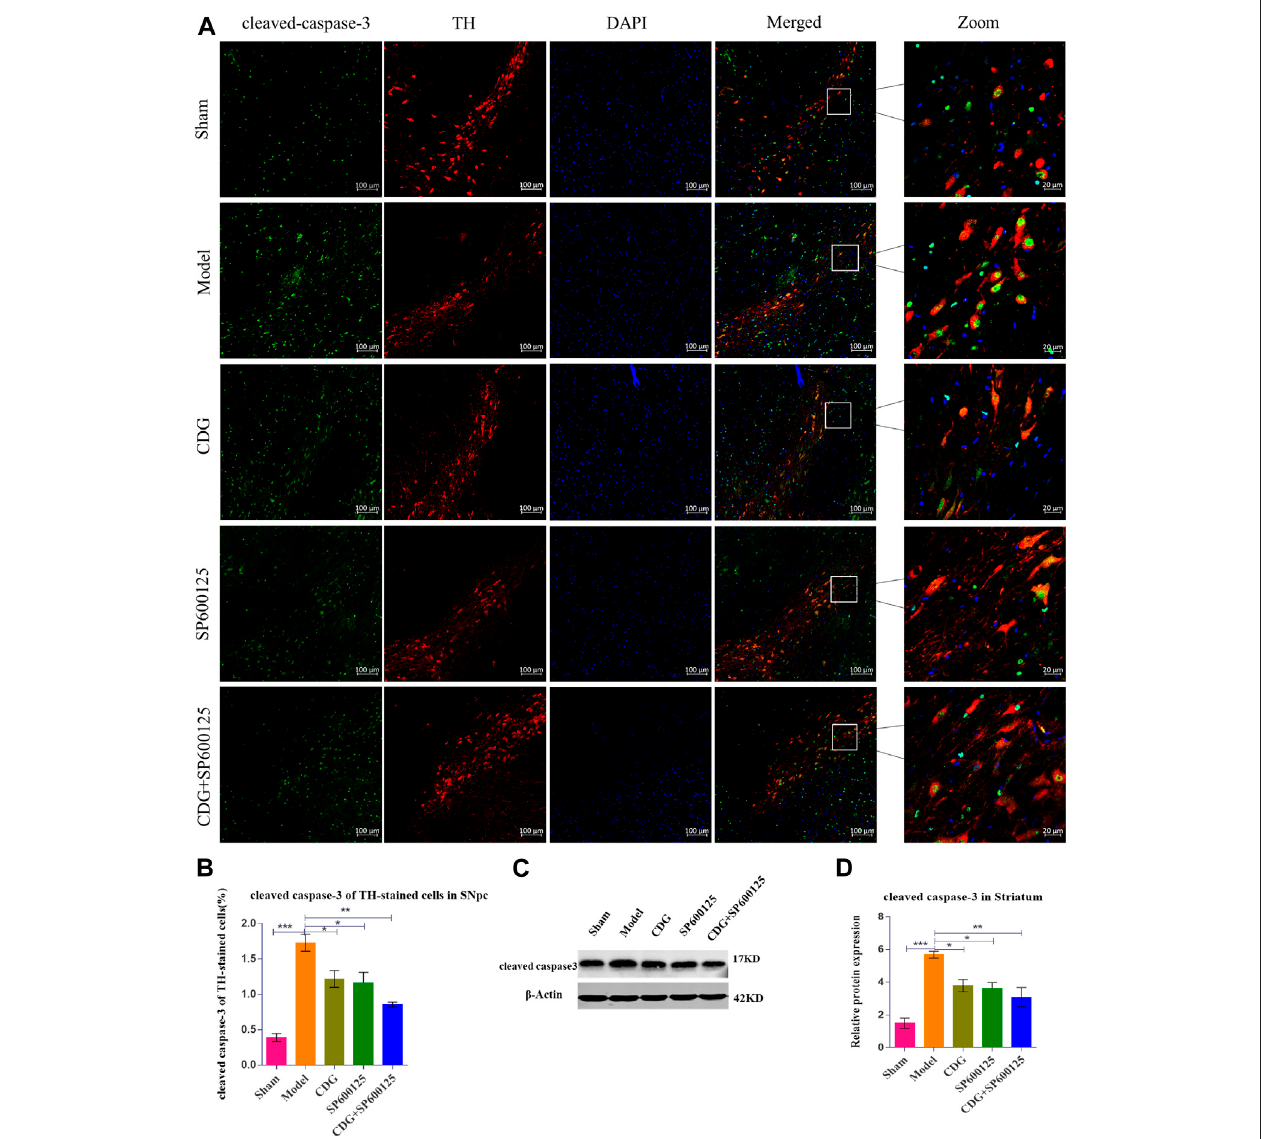
FIGURE 8 | Expression of cleaved caspase-3 protein. (A) Cleaved caspase-3 was detected by IF in each group. Cleaved caspase-3 (green), TH (red), and DAPI (blue) (scale bar (cid:1) 100 μ m; Zoomed Scale bar: 20 μ ). (B) The cleaved caspase-3 of TH-stained cells was calculated. (C – D) The expression level of cleaved caspase-3 protein was detected with Western Blot in the striatum. GAPDH served as control. Statistical analysis was performed with One-Way ANOVA, Turkey ’ s multiple comparison test, post hoc, n (cid:1) 3. Statistical analysis was performed with Two-Way ANOVA, n (cid:1) 3. Signi fi cant differences were indicated by * p < 0.05, ** p < 0.01, *** p <